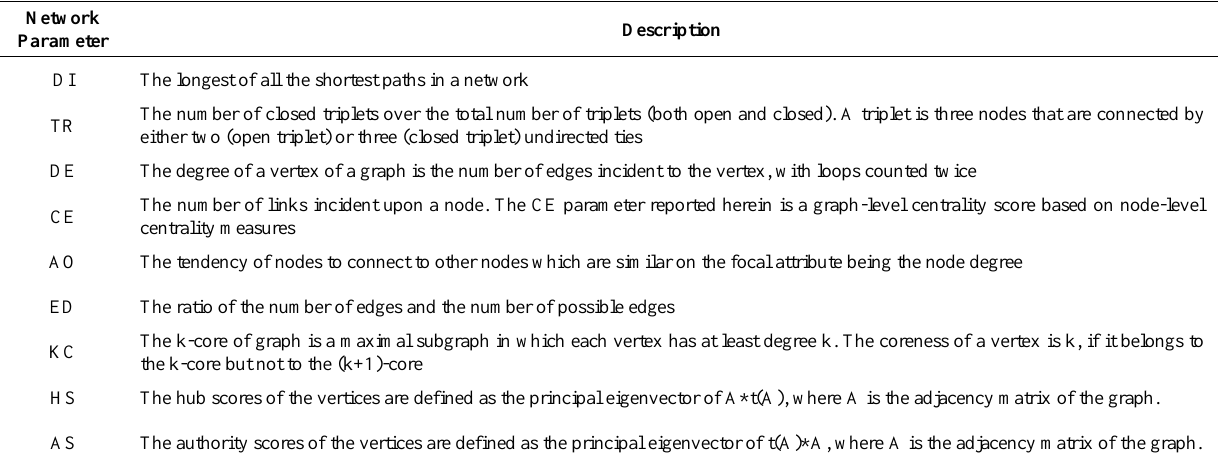
Table 1. Description of the DMN entries related to the network/graph theory Network